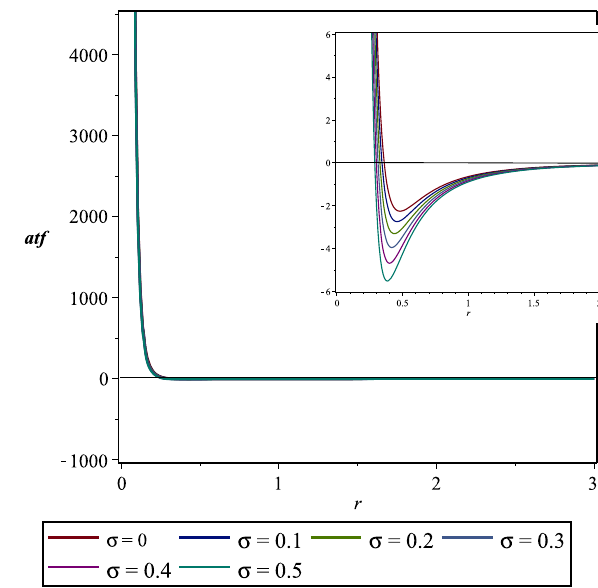
Fig. 2 Radial tidal force for a Kiselev BH surrounded by dust for cho- sen values of the dust parameter, also we have q = 0 . 6, M = 1 and b = 100